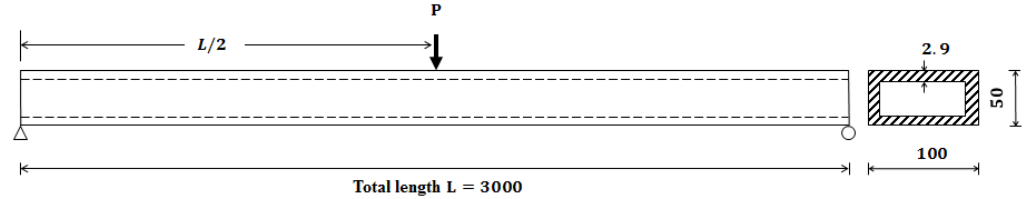
Figure 4. Specification of the simple beam (Unit: mm) [17].